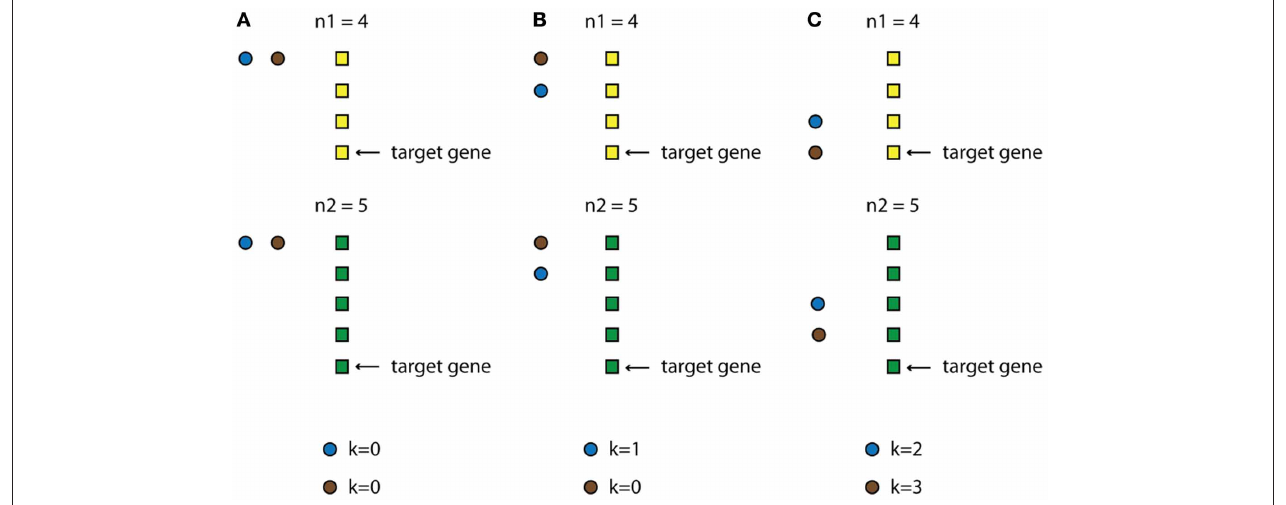
since the expression profile of the gene is also shifted in time). Every TF is allowed to be expressed at the time points 1, 2, 3, and 4 ( k represents the steps that each TF is shifted). (A) Both TFs are expressed at time point 1 ( k = 0). (B) The first (black) TF is expressed at time point 2 ( k = 1) while the second (gray) at time point 1 ( k = 0). (C) The first (black) TF is expressed at time point 3 ( k = 2) while the second (gray) at time point 4 ( k =